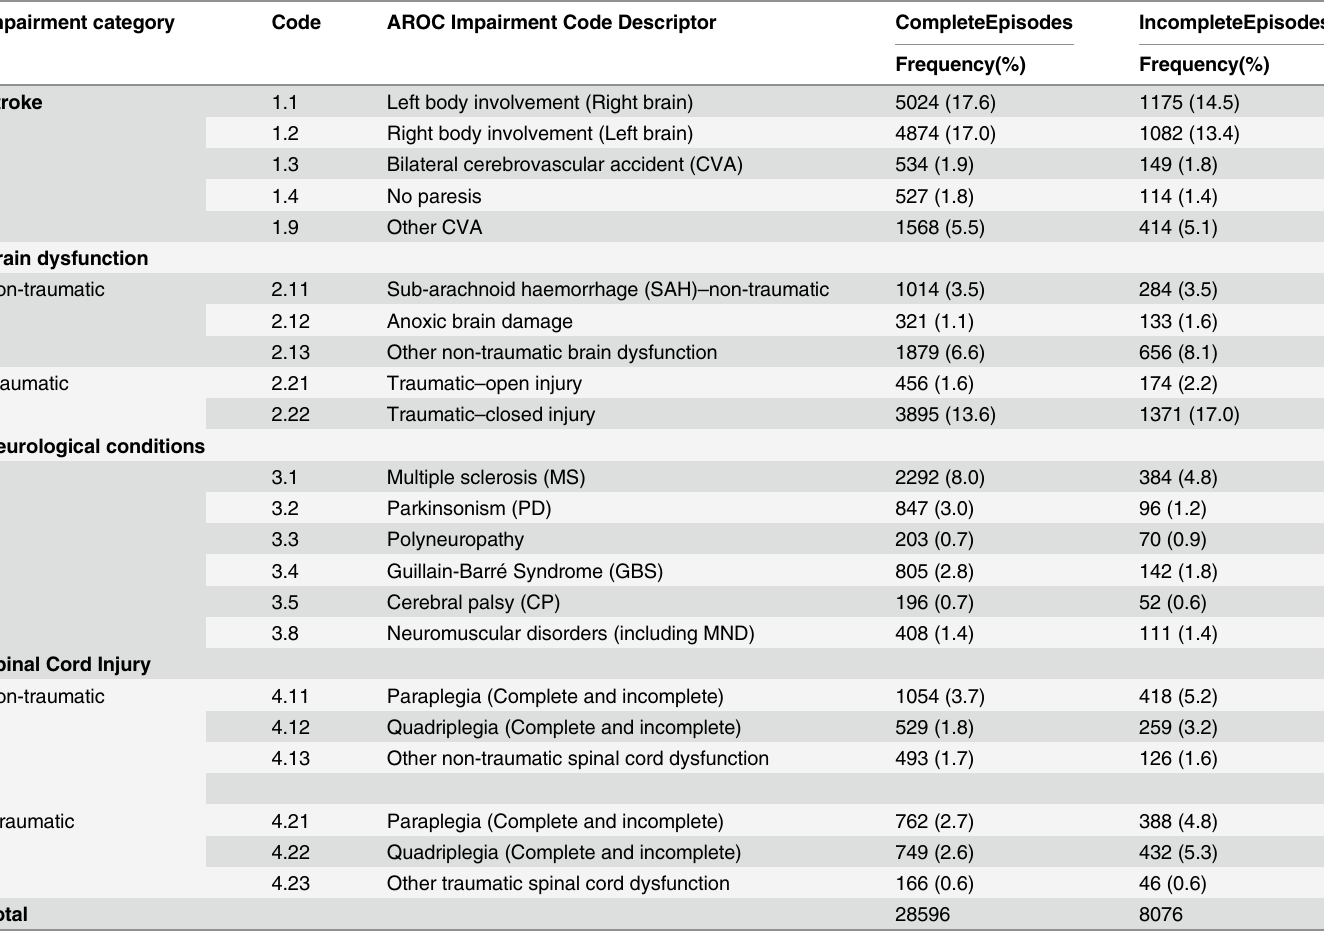
Table 1. Complete and incomplete case episodes categorised by Impairment code.